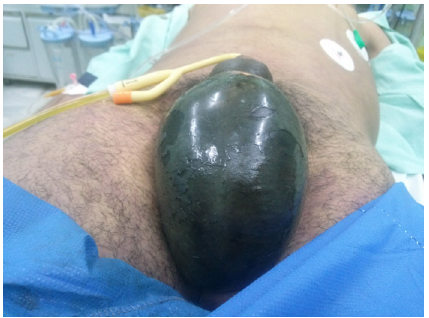
Figure 1. Necrosis and severe scrotal edema of the patient following ant bites and the subsequent